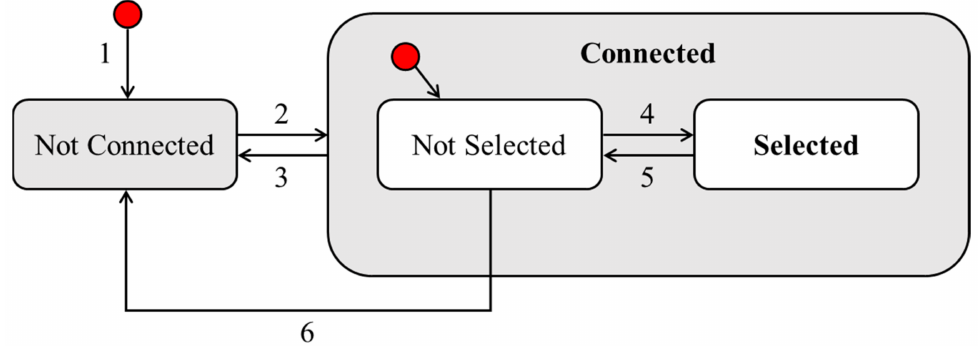
Figure 4. High-speed SECS message service (HSMS) communication connection state diagram. Table 3. High-speed SECS message service (HSMS) communication connection flow.